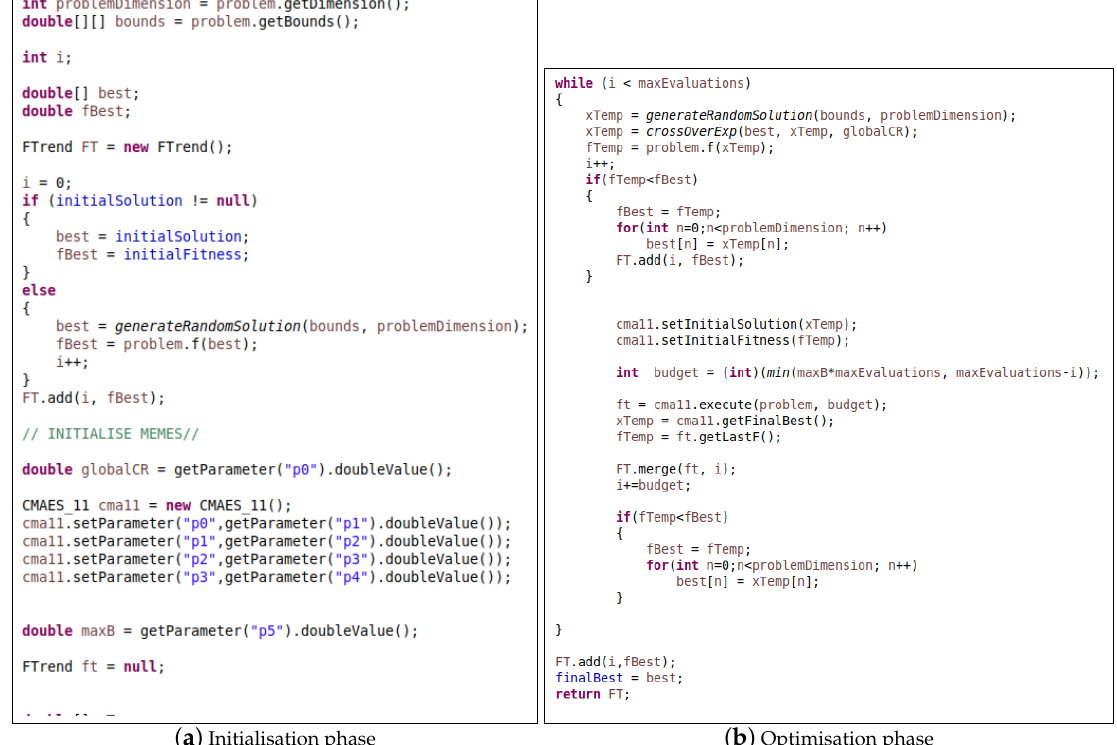
Figure 3. Algorithmic design and implementation in SOS. This example shows portions of code from the algorithm class RI1p1CAMES , located in the algorithms package, which implements the algorithm proposed in [73]. On the left-hand side ( a ), the initialisation phase, where the object cma11 , which is an instance of the class CMAES_11 (which extends Algorithms ), is initialised and ready to be executed inside another class extending Algorithms . On the right-hand side ( b ), the implementation of an iterated local search method using cma11 as a local searcher. Note that the FTrend variable ft returned by cames11 is automatically appended to FT to obtain the overall fitness